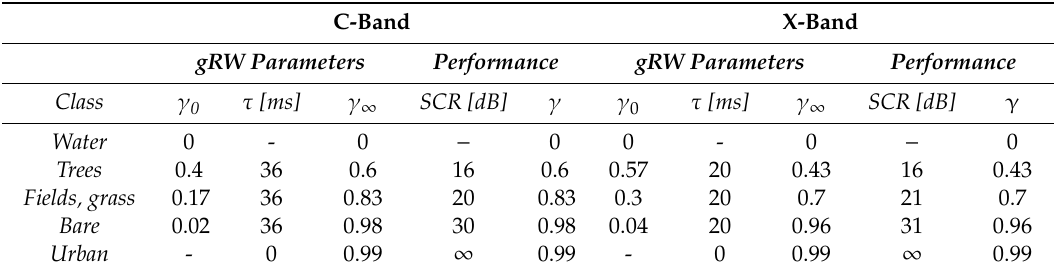
Table 2. γ ∞ parameters and performance for the GEO SAR simulation at C and X band.